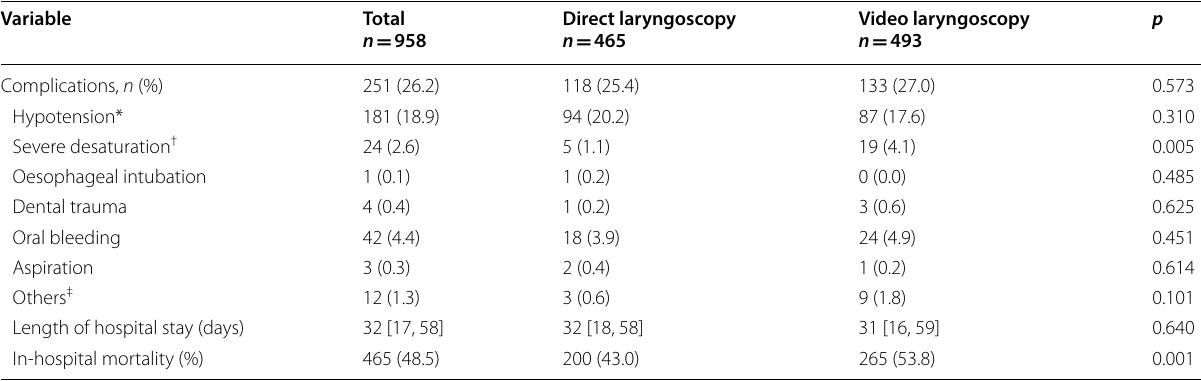
Table 4 Complications according to intubation